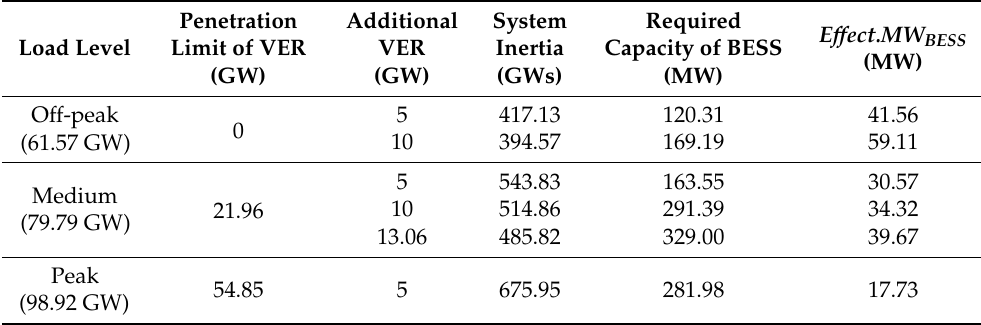
Table 5. Summary of the effect of BESS on increasing penetration limit of VER by system operating conditions.